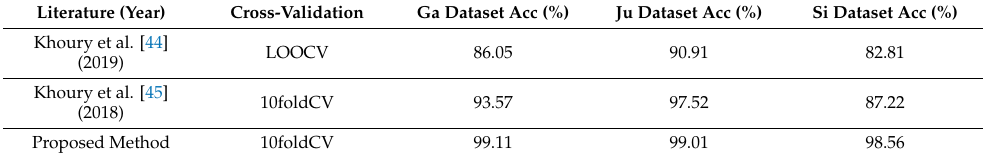
Table 26. Two-class classification results of comparisons with existing literature for each